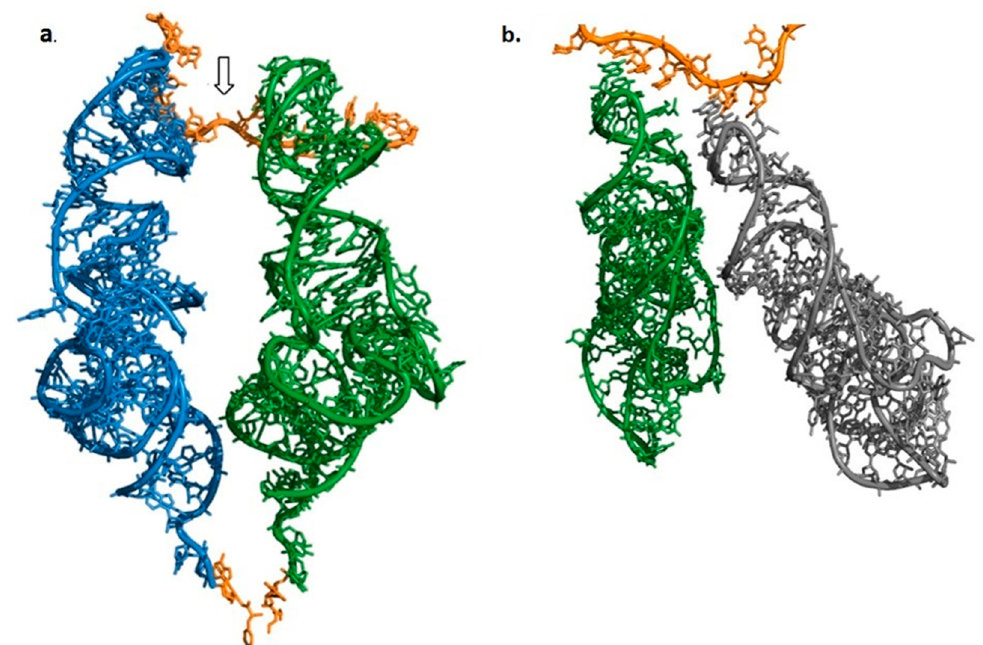
Figure 2. Juxtaposition of two tRNA molecules attached to adjacent codons on the mRNA. A-site tRNA in dark blue, P-site tRNA in dark green, E-site tRNA in gray, mRNA in orange, and the ultimate residue A76 with the attached amino acid in gold. ( a ) A-, P-site tRNAs (PDB code 1VY4) forming a rhombus-like arrangement. The kink in mRNA is marked by an arrow. ( b ) P-, E-site tRNAs, which are paired to a less kinked segment of mRNA (PDB code 4V6F), deflect.